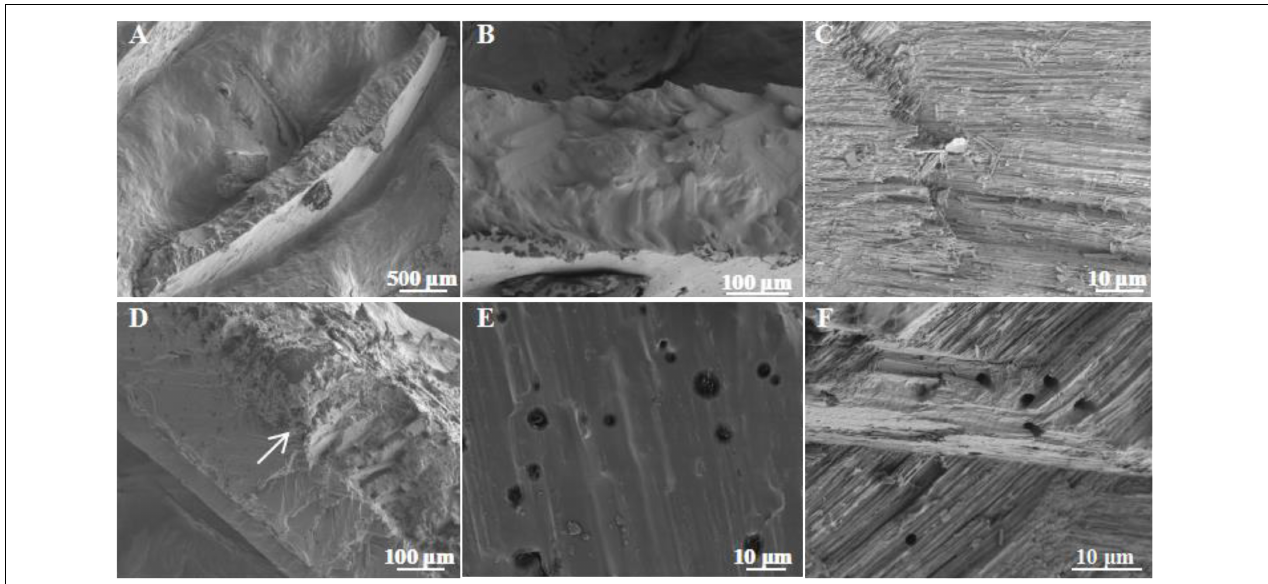
FIGURE 3 | Ultrastructure of the cross section in bio-eroded snail shells. (A) The cross section of the healthy snail shell; (B,C) the ultrastructure of the cross section of the healthy snail shell; (D) the cross section of the bio-eroded snail shell; (E,F) the ultrastructure of the cross section in the bio-eroded snail shell, with many small pores with low void